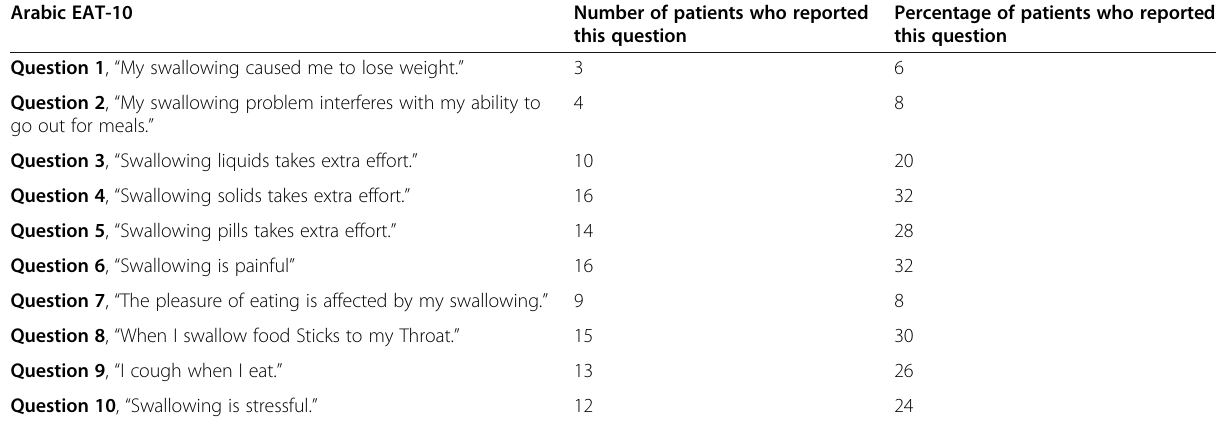
Percentage of patients who reported this question this question